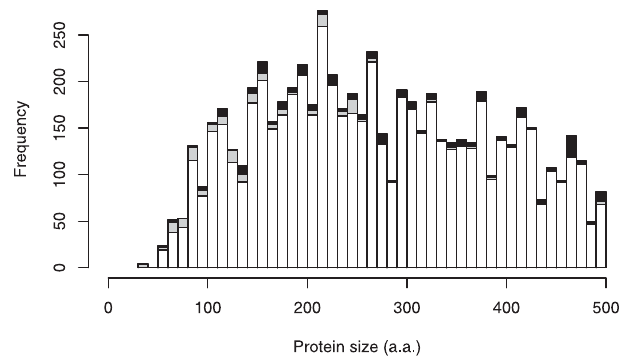
Figure 2. Slight Length Dependence of CRITICA Predictions Black bars indicate all mouse Swiss-Prot proteins in FANTOM. Grey bars indicate the subset of these that use the most upstream possible start codon. White bars indicate the subset of the mouse Swiss-Prot proteins in FANTOM that are predicted by CRITICA. DOI: